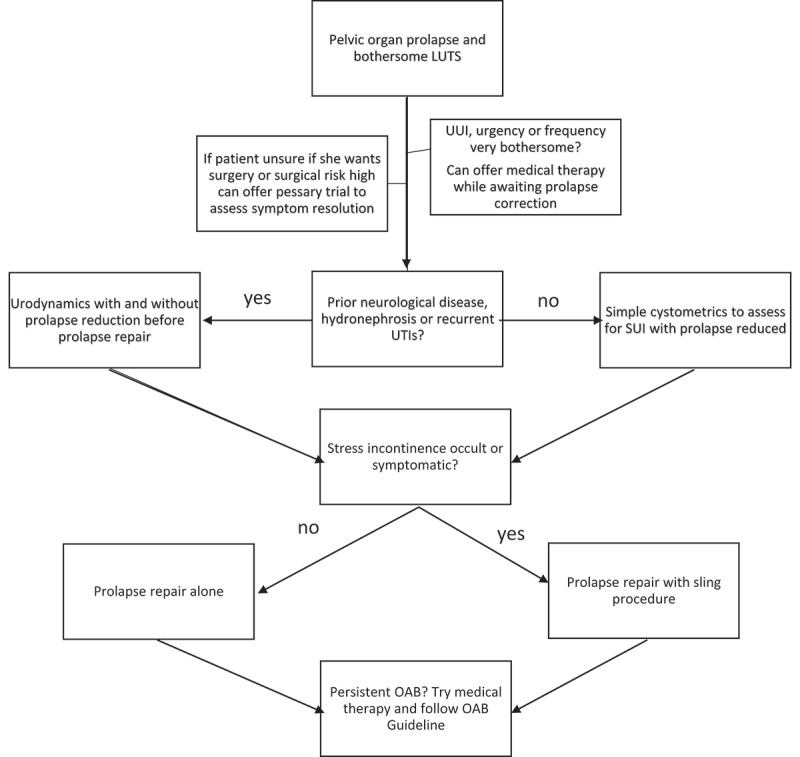
Flow chart of treatment options for women with POP and bothersome LUTS.